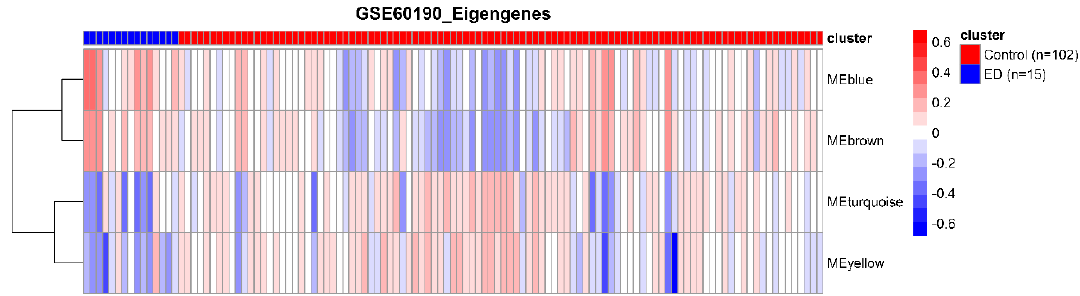
Figure 3. Heatmap of eigengenes. x-axis shows the cluster of cases (blue) and controls (red), y-axis shows the dendrogram of identified modules.